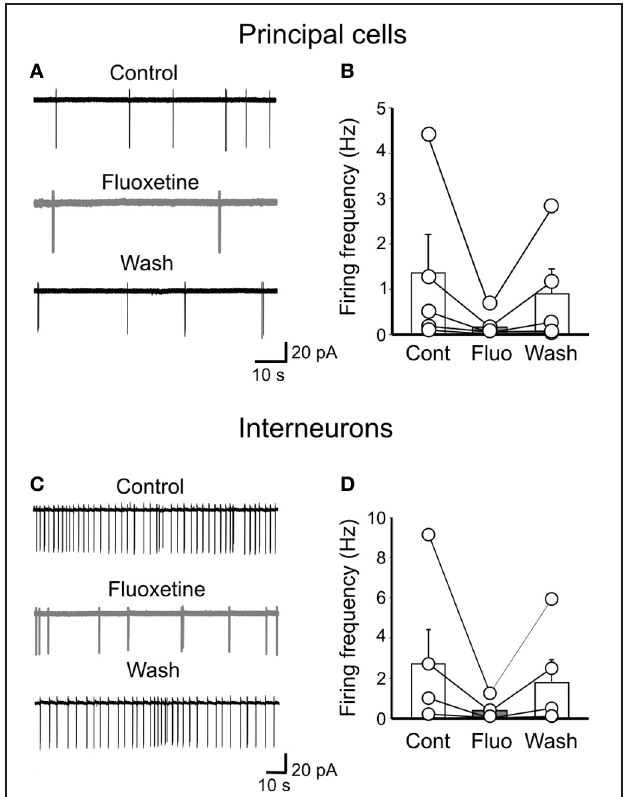
FIGURE 8 | Fluoxetine reduces the firing rate of principal cells and interneurons. (A) cell attach recordings of a pyramidal cell before, during and after (Wash) application of fluoxetine (20 μ M). (B) Population graph of the firing frequency of pyramidal cells ( n = 5) before (Cont), during (Fluo) and after application of fluoxetine (Wash). Columns represent the mean, bars the SEM. The effects of fluoxetine were significantly different from controls ( p < 0 . 05). (C,D) as in (A,B) but for GABAergic interneurons in stratum radiatum ( n = 5; p < 0 .